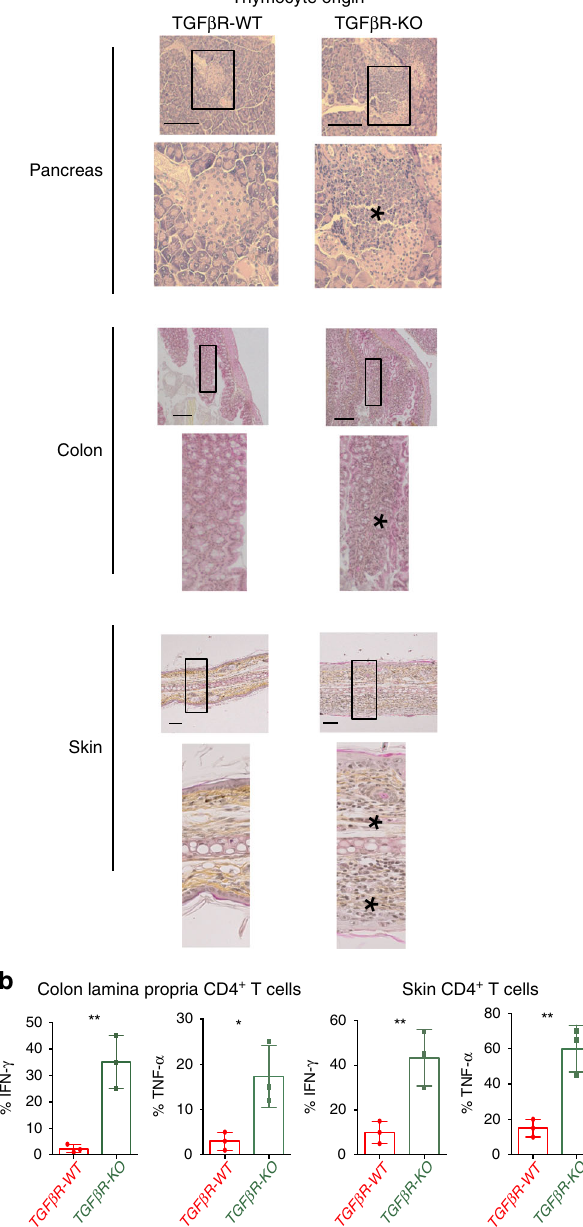
Fig. 6 Mature thymocytes from TGF β R-KO mice lead to multiple organ autoimmunity. CD3-KO mice were grafted with FACS-sorted CD4 SP (CD69 − , CD24 Low , Qa2 + ) thymocytes from either TGF β R-WT mice or TGF β R-KO mice. Recipients and donors were 7 – 10 days old on the day of the transfer; 8 weeks after being grafted, the recipients were analyzed. a Representative micrographs of H&E-stained tissue sections of indicated organs; * indicates the in fi ltrates. Data are representative of 2 experiments with 3 animals per group. Scale bars, 50 µ m (magni fi cation 3×). b Cells in fi ltrating the lamina propria of the colon as well as the skin were isolated and analyzed by fl ow cytometry. Graphs demonstrate the percentage of CD4 + T cells producing IFN- γ or TNF- α . Data are representative of 2 experiments with 3 animals per group. ** P < 0.01 (two-tailed Student ’ s t test). Error bar, mean ± SEM. Source data are provided as a Source Data fi le.